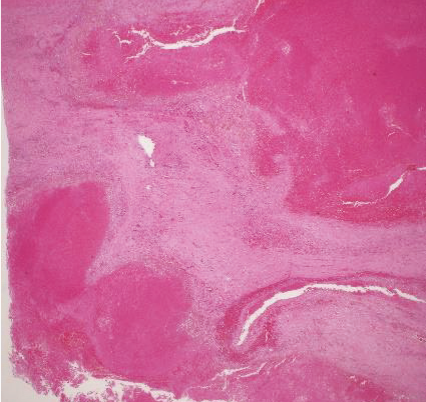
Figure 3: The resected specimen consisted mostly of a hematoma and some vessel